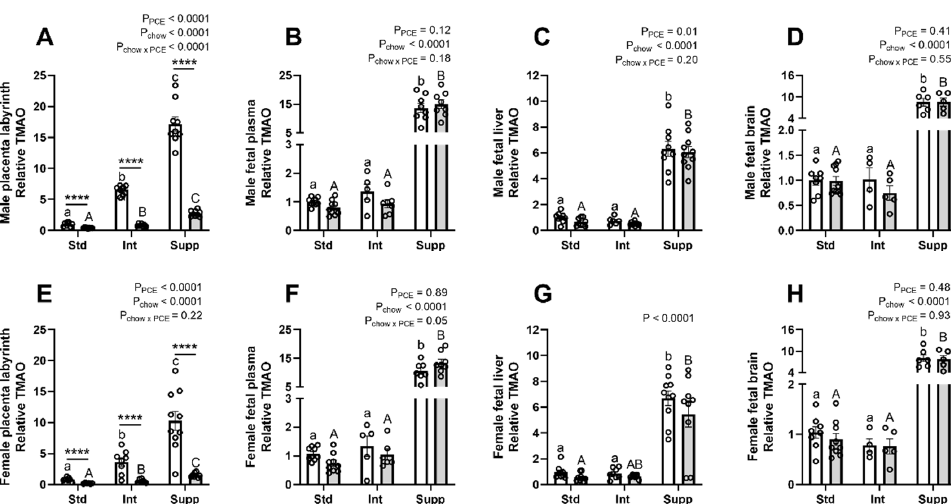
Figure 8. The effects of periconceptional ethanol and choline supplementation on trimethylamine oxide (TMAO) levels in placentas of male and female fetuses ( A , E ), male and female fetal plasma ( B , F ), male and female fetal liver ( C , G ), and male and female fetal brain ( D , H ). During the periconceptional period, dams received a control liquid diet (Con; open bars) or a liquid diet containing 12.5% v / v ethanol (PCE; grey bars). For the remainder of pregnancy, dams received either standard chow (Std), intermediate chow (Int), or supplemented chow (Supp), with increasing levels of choline across these groups (1.6 g, 2.6 g, or 7.2 g choline/kg chow), n = 4–9 per group. Molecules were measured using mass spectrometry and data expressed as fold-change relative to the average of the male Std-Con group (mean ± SEM). Significant differences due to alcohol exposure or chow group were identified via two-way ANOVA and Tukey’s post hoc analysis. **** p < 0.0001 for differences between Con and PCE within each chow group; chow effects between Con groups are shown by lower-case letters, and between PCE groups by upper-case letters.